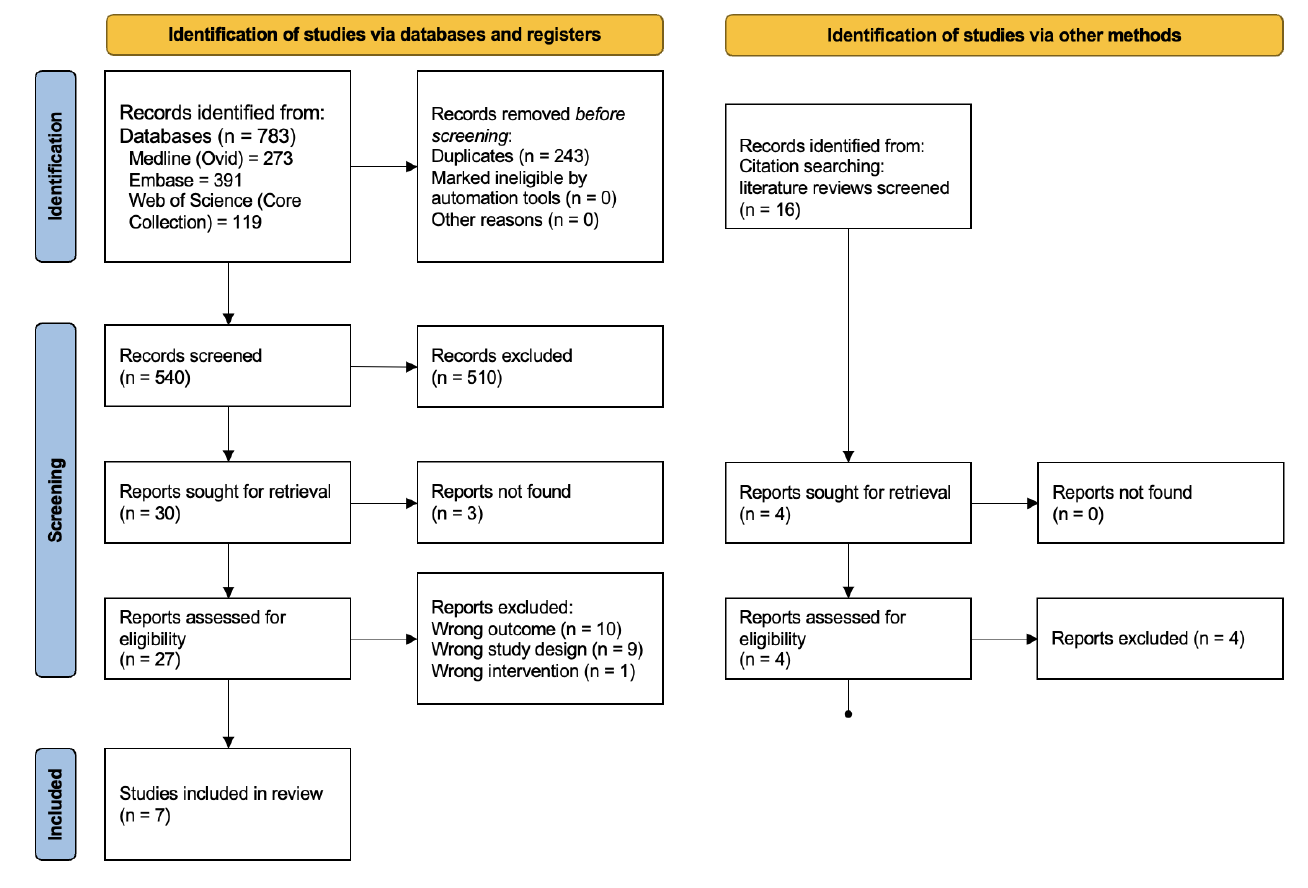
Figure 2. Systematic review study selection PRISMA flow diagram.